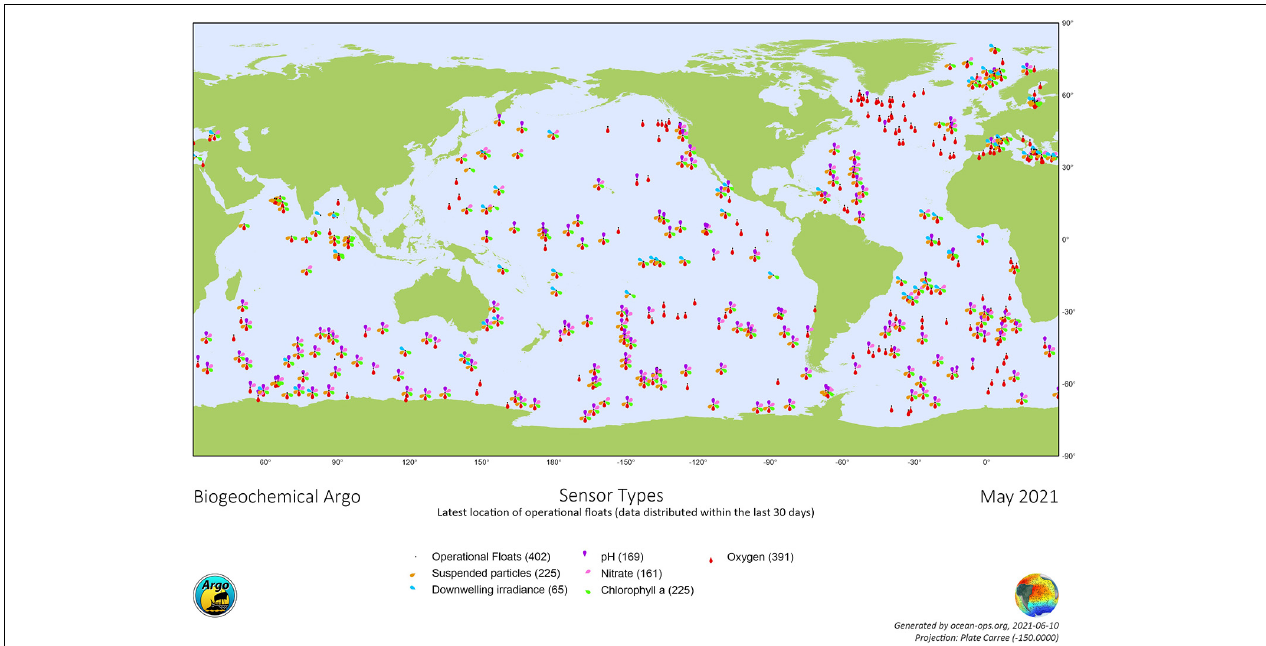
FIGURE 1 | Map depicting active floats and their equipped sensors (color classification), as of May 2021. For updated maps see the Biogeochemical-Argo website. Up to 40548 downwelling irradiance profiles have been acquired as of May 2021 (for an updated summary, see the Bio-geochemical-Argo website